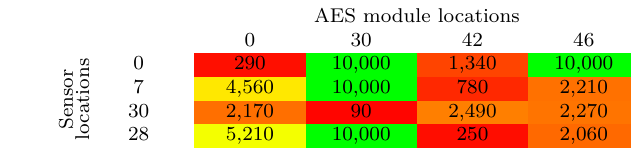
Figure 11: Minimum amount of traces ( × 1 , 000) required for all possible combinations of AES and sensor location on a Virtex-7-based ADM-PCIE-7V3 accelerator card. Here, a value of 10 M means that we were unable to recover the key with 10 M traces.